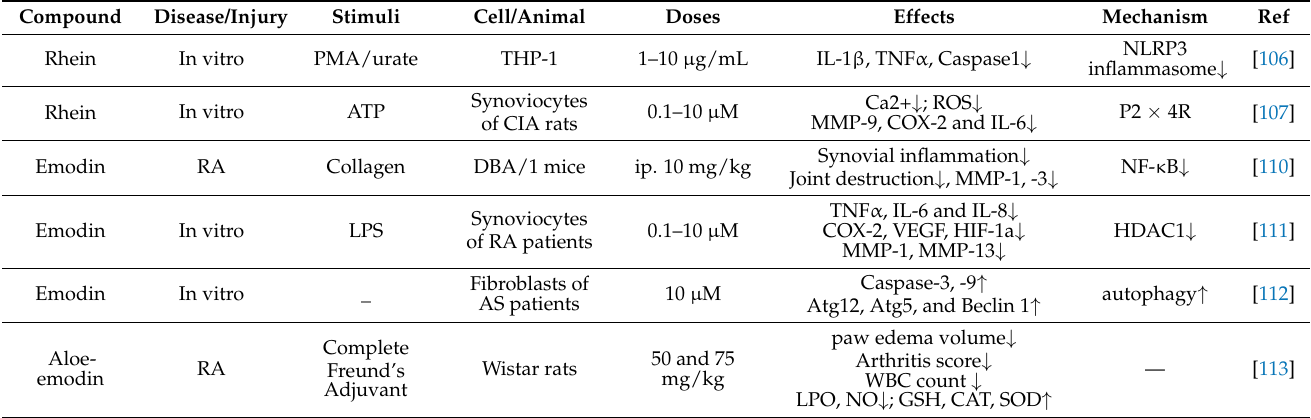
Table 4. Effects and mechanism of AQs on